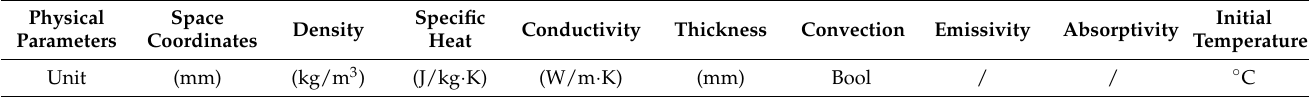
Table 1 Point cloud data format for 3D targets. Table 1. Point cloud data format for 3D targets.